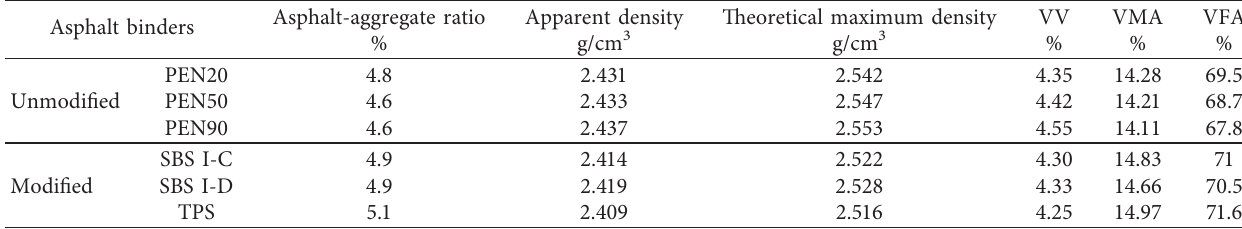
Table 3: Testing data of the asphalt mixture Marshall